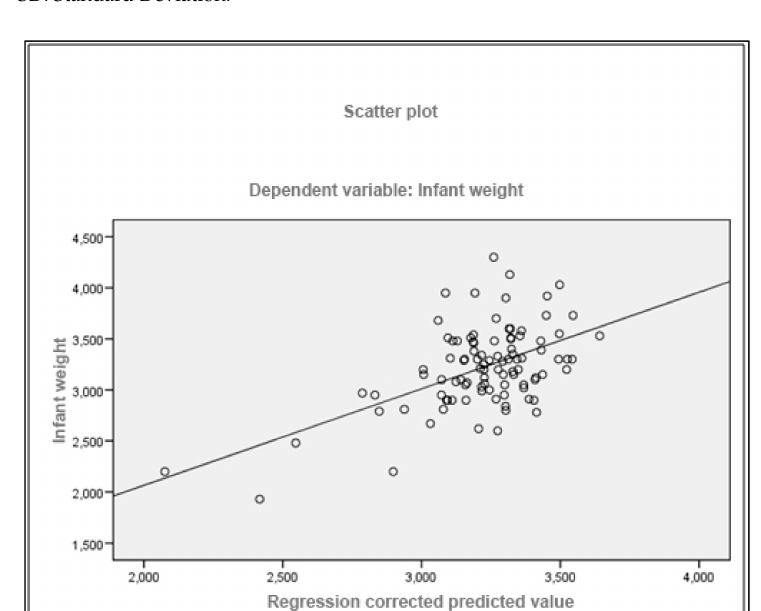
Figure 2. Scatter plot considering birth weight as the dependent